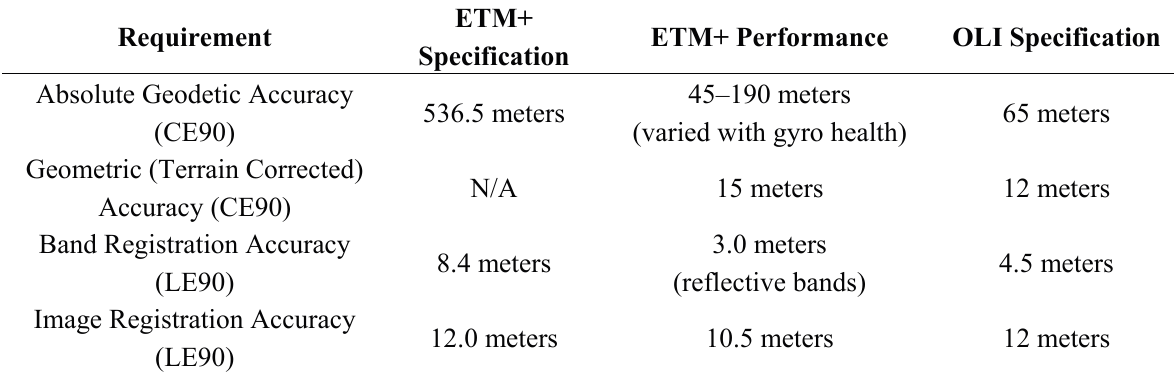
Table 1. Landsat 7 ETM+ and Landsat 8 OLI geometric performance